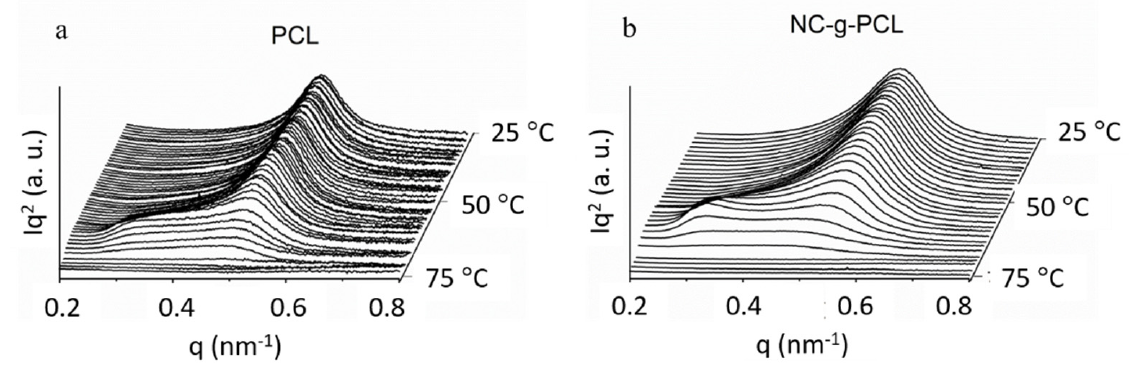
Figure 9. Scattering (SAXS) spectra with temperature for pristine PCL ( a ) and NC-g-PCL ( b ). The melting temperatures obtained by SAXS were in agreement with the values obtained by DSC